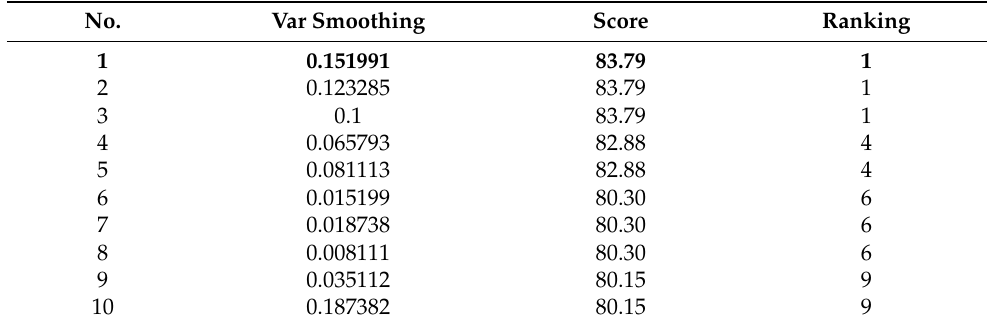
Table 8. Naïve Bayes hyperparameter-tuning